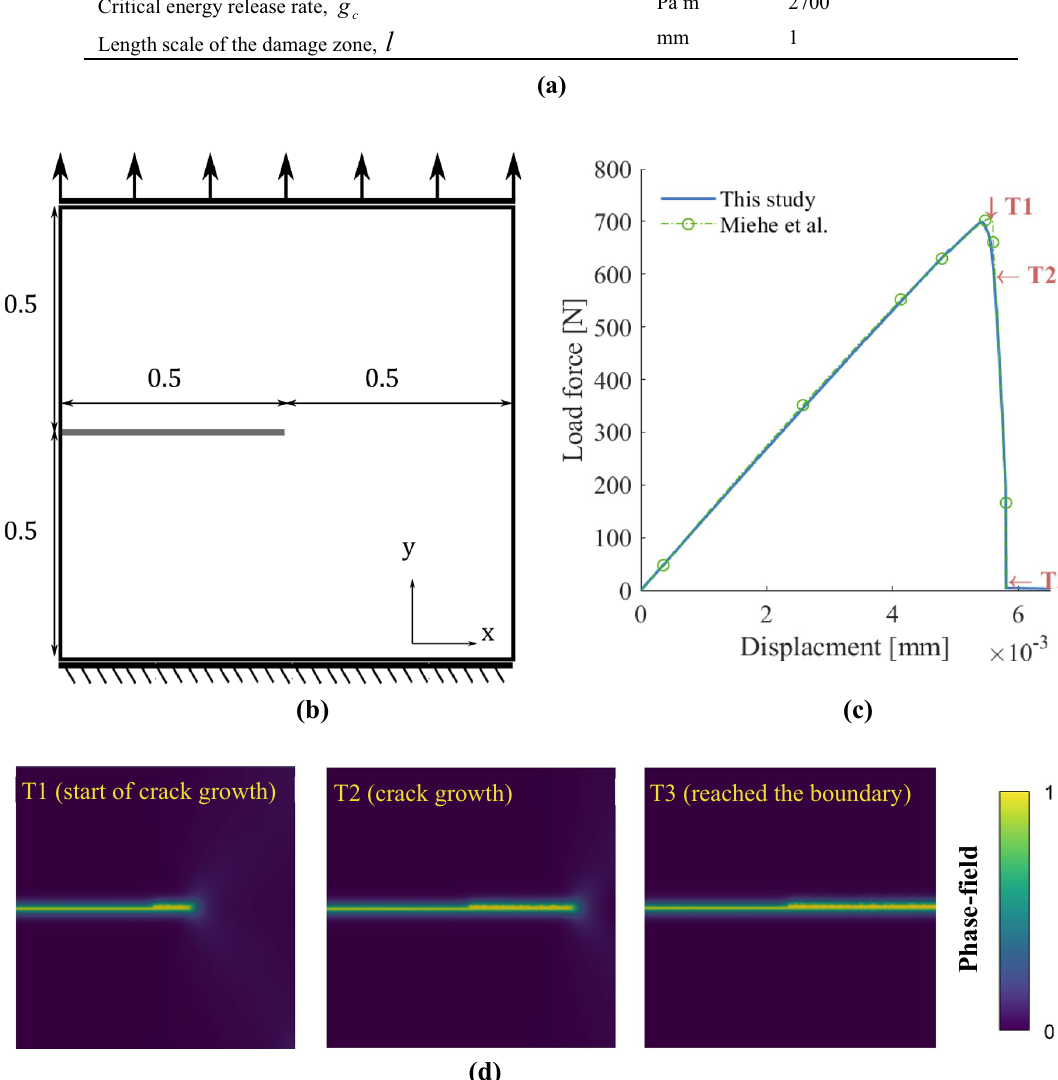
Figure 3. ( a ) model parameters used for the single-edge notched tension test 34 . ( b ) Illustration for of the single edge notched tension test domain with the dimensions and boundary conditions. ( c ) Computed load–deflection curve versus vertical displacement. The peak of the curve corresponds to a fully developed fracture. The results are consistent with those of 30 . ( d ) Phase-field contours showing the fracture evolution at three-time steps (T1, T2, and T3) during the simulations. As the displacement at the top boundary increases, the fracture nucleates and grows following a horizontal consequence of an increase in the permeability near the damage zone. Figure 4d and 4e show the permeability and the pressure profile along the y-axis from the fracture tip to the boundary at 15 and 25 s. The increase in perme- ability allows the water to flow further away from the fracture, which explains the slower pressure buildup around the fracture. After 28 s, the fluid pressure peaks and then decreases sharply. We denote this as the breakdown pressure (Fig. 4c). Between 28 s < t < 35 s, the remaining energy in the system drives fracture propagation. We observe that the fluid pressure around the notch region keeps decreasing, which is consistent with Darcy’s rela- tion due to the increased permeability from the expanding fracture and associated hydraulic aperture increase. Our framework captures the overall underlying physics as explained by Ha et al.’s model 44 and Feng et al.’s model 43 . The three models predict similar breakdown pressures but deviate, especially during the ~ 20 s period